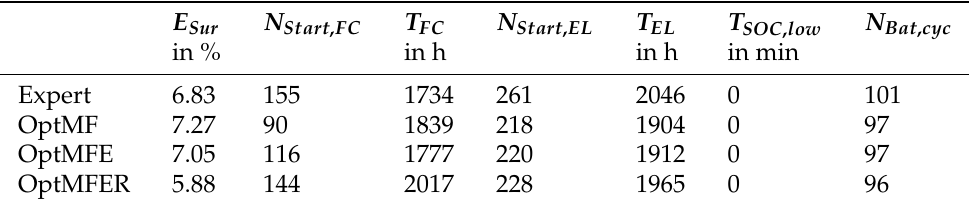
Table 6. Results of simulation runs for household No